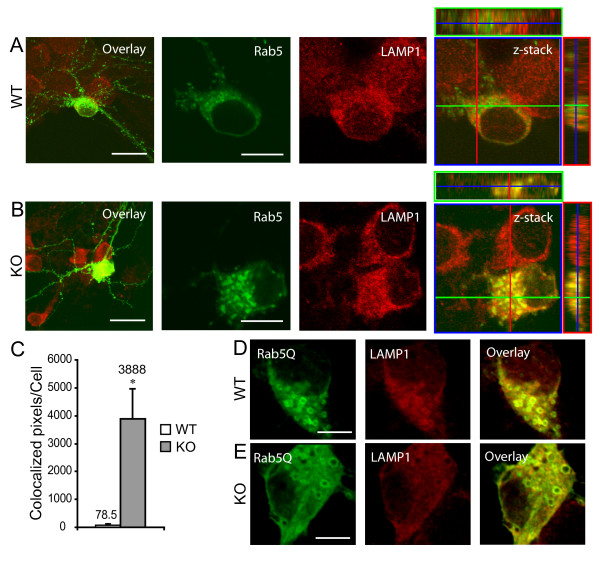
Increased co-localization of LAMP1 with Rab5-associated vesicles in ALS2-/- neurons. (A-D) A lower (left) or higher magnification of Rab5-transfected wild-type (WT, A), or ALS2-/- (KO, B) neurons co-stained with LAMP1 (red) and GFP (green) antibodies. Co-localization of LAMP1 (red) and Rab5 (green) in WT and KO neurons was revealed by z-series stack images. Scale bars = 20 μm (left) and 10 μm (the rest) respectively. C. Quantitative analysis of co-localization of LAMP1 and Rab5 immuno-reactivity in WT (n = 4) and KO (n = 7) neurons. Error bars indicate SEM. * P < 0.05. D-E. In the soma, LAMP1 (red) and Rab5Q (green) were co-localized in either GFP-Rab5Q-transfected wild-type (WT, D) or ALS2-/- (KO, E) neurons. Scale bar = 20 μm.